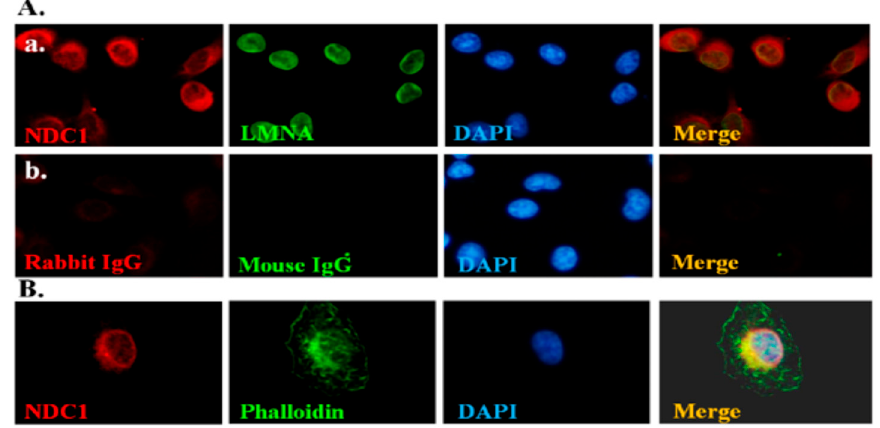
Figure 3. NDC1 location near the nuclear envelope in the male germ cell line. IFA results depicting the signals of ( A ) ( a ) FLAG-NDC1 using NDC1 (red), LAMNB1 (green), DAPI (blue), and a combination of NDC1, LAMN, and DAPI (“Merge” panel) stains; and ( b ) control IgG. Magnification = 400 × . IFA results depicting the signals of ( B ) FLAG-NDC1 using NDC1 (red), Phalloidin (green), DAPI (blue), and a combination of NDC1, Phalloidin, and DAPI (“Merge” panel) stains. Magnification = 400 × .